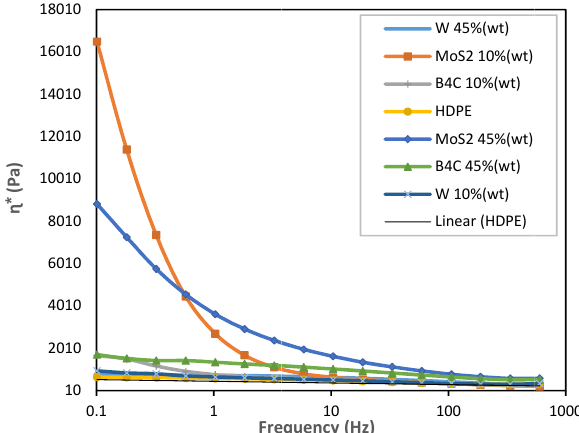
rradiation by Sc